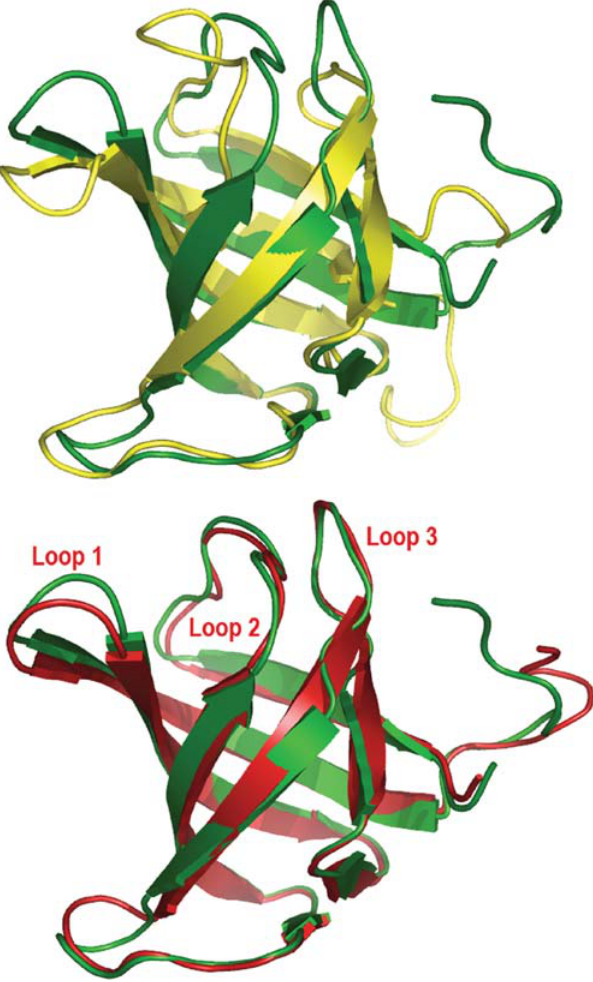
Figure 3. Overlays of a crystal structure with its unrefined and refined homology models The crystal structure: green, Protein Data Bank ID: 1XE1; the unrefined homology model: yellow, provided by the Protein Structure Prediction Centre (TMR01, http://predictioncenter.org/caspR/); the refined homol- ogy model: red, refined from TMR01 using the same protocol [15] for the 3D model of Anopheles gambiae acetylcholinesterase.